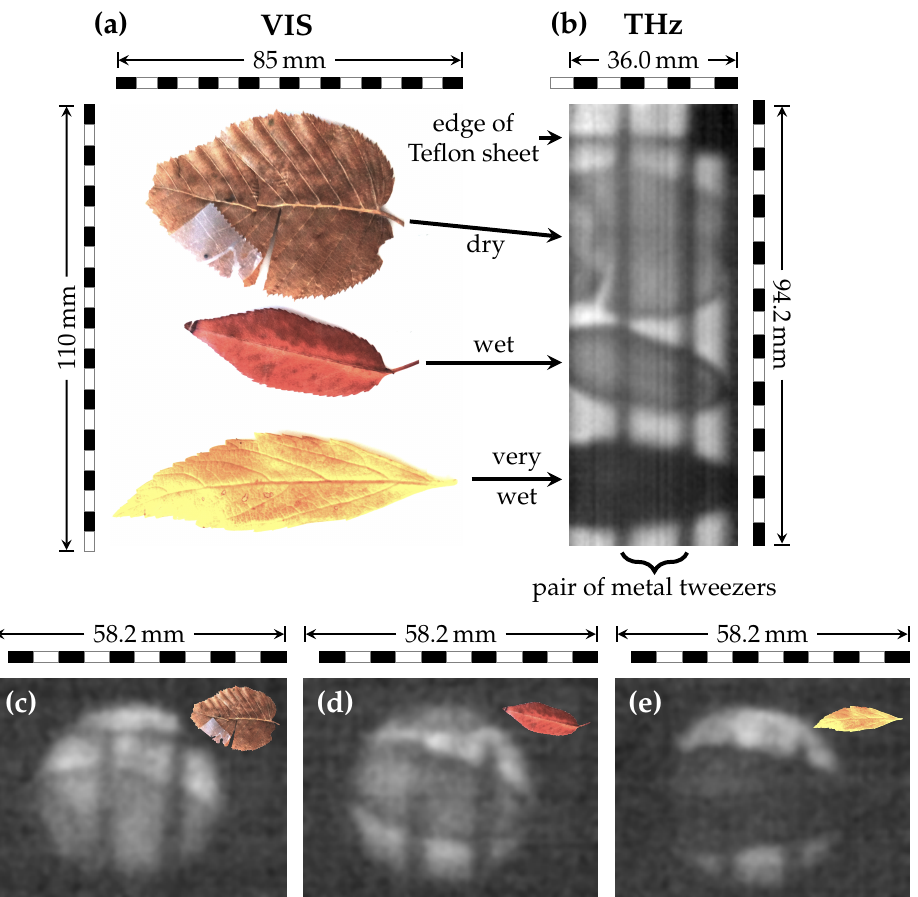
Figure 6. ( a ) Photography (VIS) of leaves with different water contents. One leaf stored in a drawer for five years (top) and two found just prior to the experiments: one from a dry place (middle) and one from a wet gutter (bottom). Glued with THz transparent adhesive tape onto a 1mm thick Teflon sheet, Teflon and tape stripes removed by image processing for better visual clarity, and partially still visible. THz image of the different leaves ( b ) with a pair of tweezers for contrast enhancement (vertical lines) and the edge of the Teflon sheet (top, horizontal) visible. Higher water contents are clearly represented by decreased brightness. Image stitched with auto-correlation from single frames of a real-time 1D scan. An exemplary post-processed single frame is presented for the dry ( c ), wet ( d ) and very wet ( e )